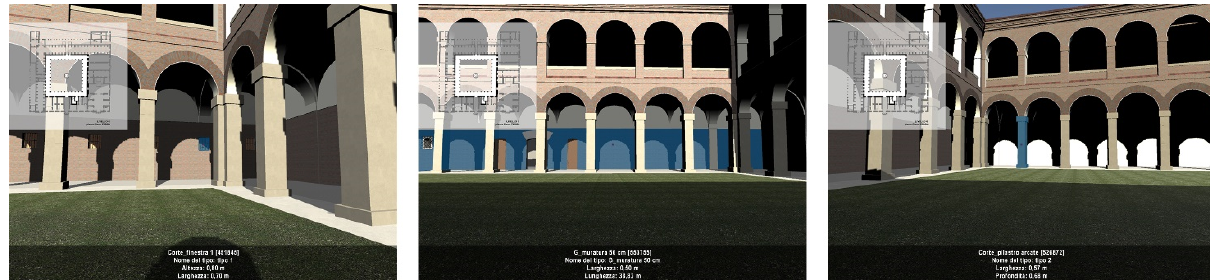
Figure 11: H-BIM scene : smart-objects selection (in blue) and visualization of related metadata in VR environment.